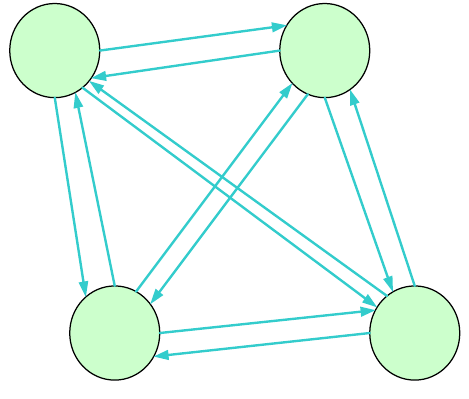
Figure 2: Recurrent neural network